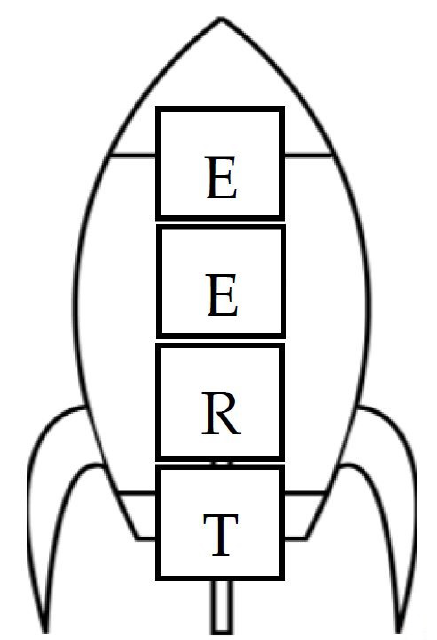
Figure 2. The rocket image to check the presence of the TREE